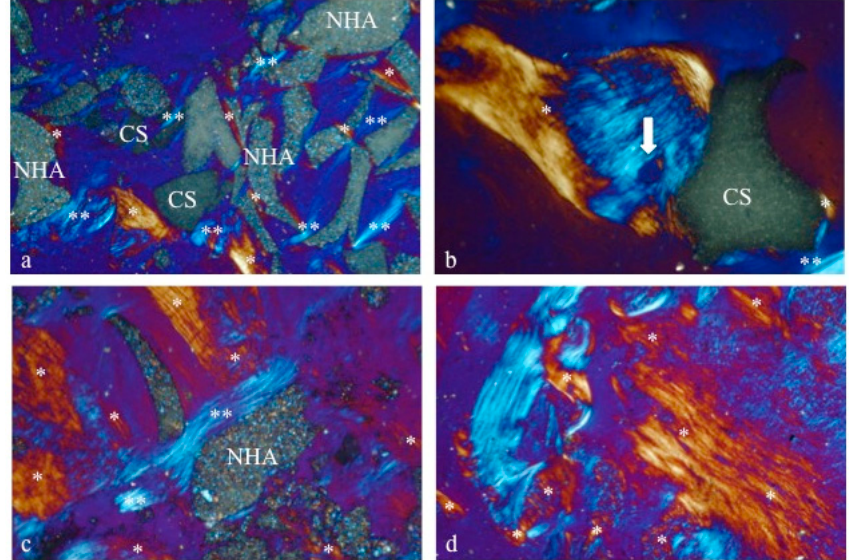
Figure 7. Under circularly polarized light (CPL), the differences in the microstructure and relationship between the two biomaterials and the newly formed bone could be observed. The new bone, surrounding some CS particles, showed vessels (white arrow in picture b indicates a Volkman Canal). Moreover, the intimate contact between the new bone (*) and the biomaterials (CS and NHA) revealed clearly the osteoconduction properties ( a , b , c , d ). CS: Calcium sulphate; NHA: Sintered nanohydroxyapatite; *: Newly formed bone; **: Desmoplastic connective tissue. Original magnification 100×.